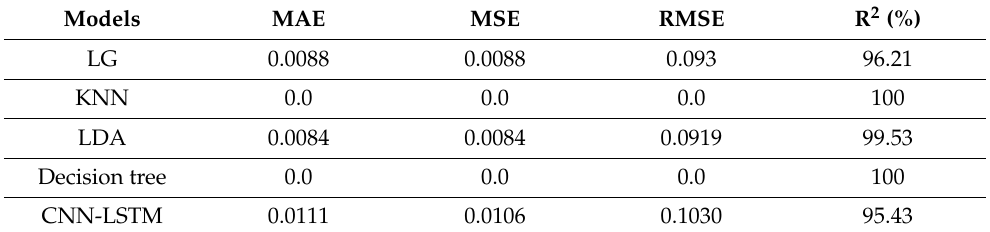
Table 13. Sensitivity analysis of ML using binary classification.